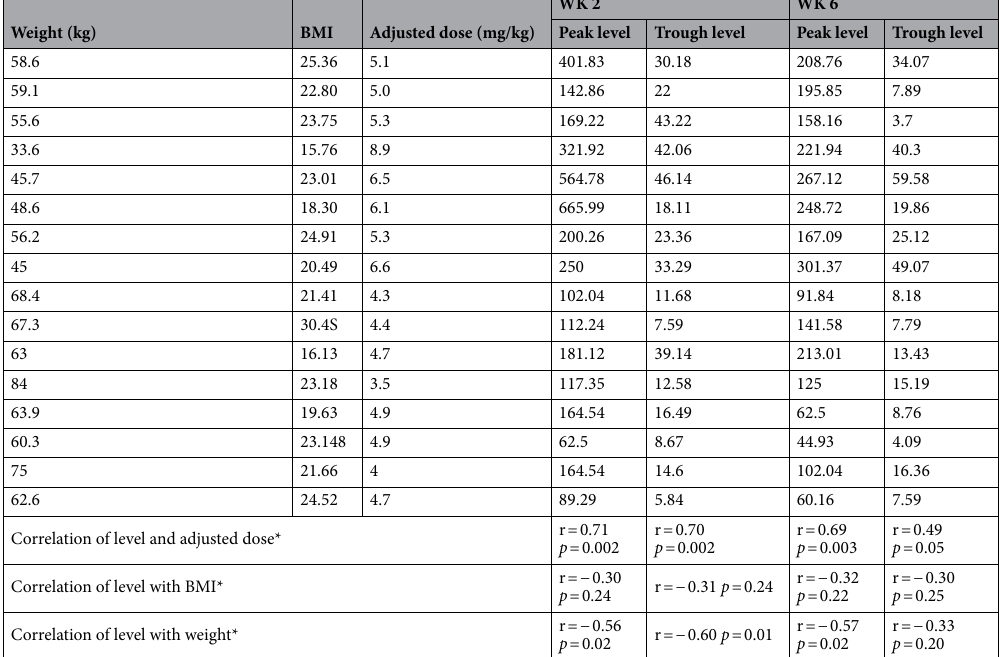
Table 4. Correlation of adjusted dose of vedolizumab with its peak and trough levels. r Spearman correlation coefficient. *Type of statistical